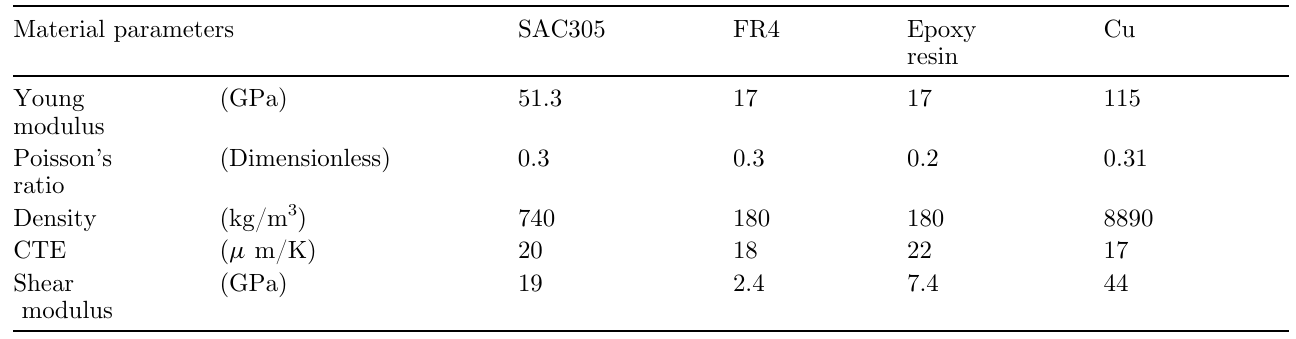
Table 3. Material ’ s